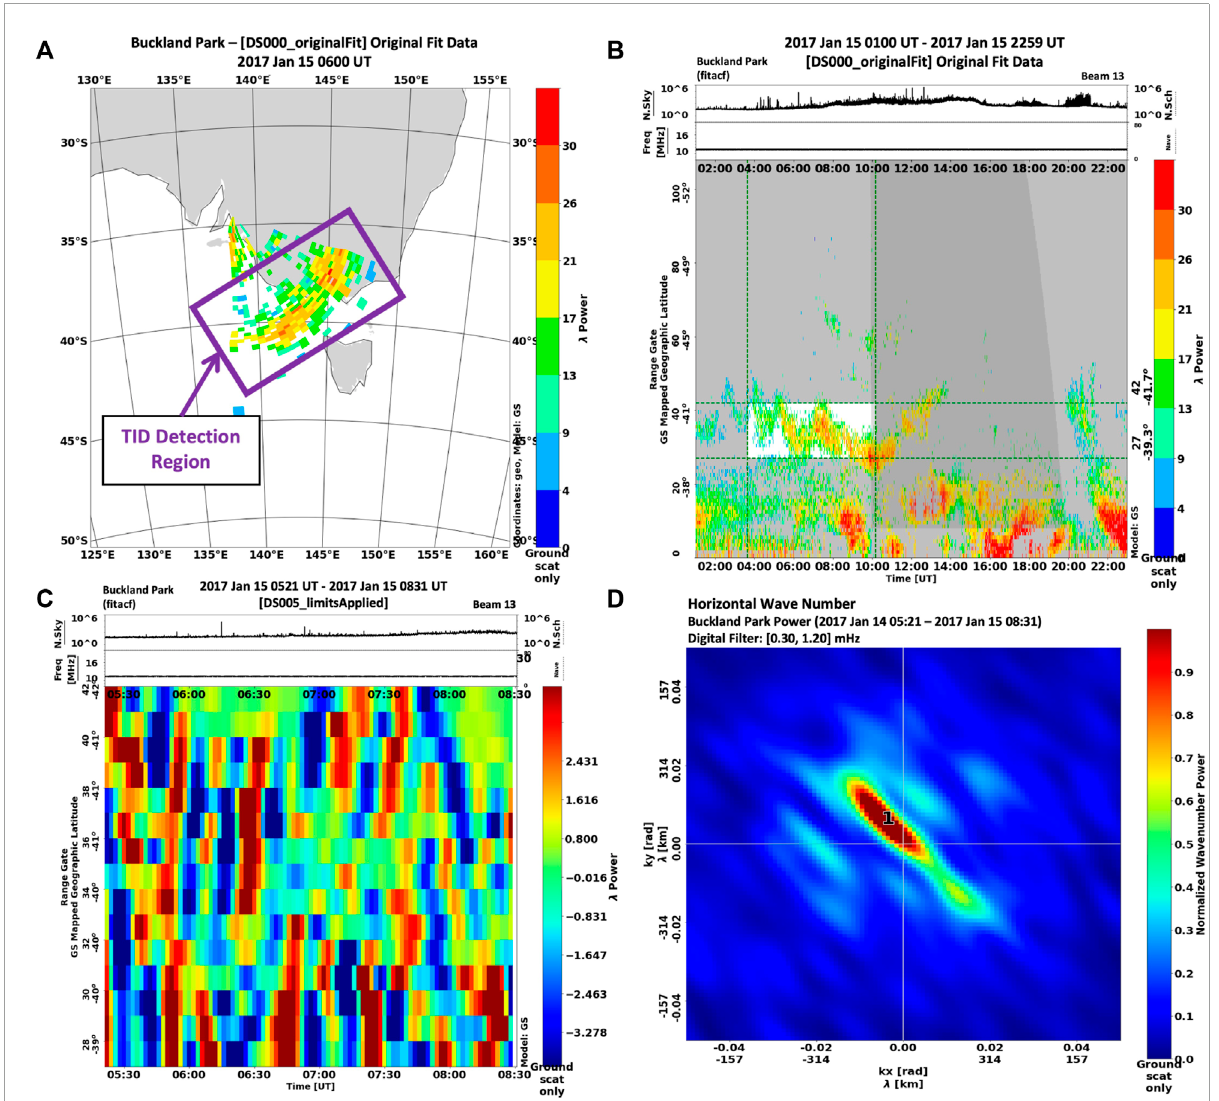
FIGURE 8 Selected outputs from an analysis conducted with the Tholley and Frissell (2022) MUSIC package using ground scatter power observations from the Buckland Park (BPK) SuperDARN radar made on 15 January 2017. (A) Fan plot of one scan of raw data using Ground Scatter Mapped Range estimation. The band of ground scatter where the TID can be detected is indicated by a purple box. (B) RTP plot with times and ranges selected for TID processing highlighted in white. (C) RTP plot showing data interpolated in space and time and filtered with a T = 14 − 56 min bandpass filter. (D) Final wavenumber array indicating the presence of TIDs observed in the radar data. Distance from the origin indicates wavelength, with shorter wavelengths farther away from the origin. Clockwise angle relative to the +y axis indicates propagation direction relative to geographic North. The hotspot marked 1 has a horizontal wavelength λ h ≈ 890 km, horizontal phase speed v h ≈ 430 m s −1 propagation azimuth ϕ azm ≈ − 45 ° , and period T ≈ 35